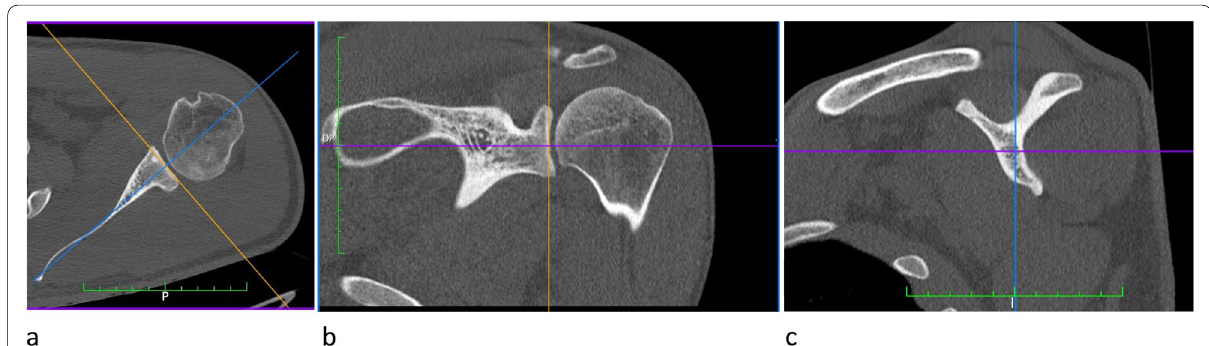
Fig. 1 The reference planes were defined using the 3D multi‑planar reformat (MPR) mode to enable direct measurement of dimensions and angles in all three planes: a An axial slice passing close to the glenoid equator was used to locate the scapular axis, passing through the medial border of the scapula and the centre of the glenoid; b The coronal view was used to locate the glenoid equator more accurately, and the corresponding axial slice was used to finetune the scapular axis; c The para‑sagittal view (parallel to glenohumeral joint space) was used to locate the ‘Y‑plane’, by scrolling from lateral to medial until both superior and inferior cortices of the scapular spine were in continuity with the body of the